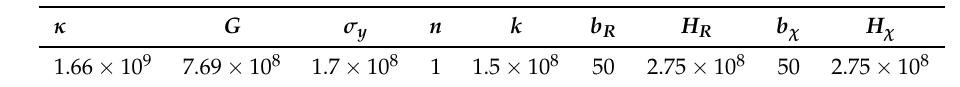
Table 2. The model parameters.